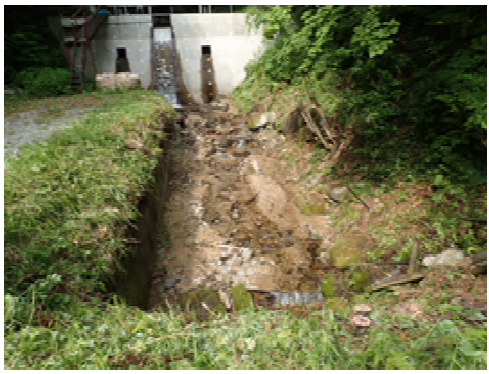
Figure 2. Study section of the mountain channel